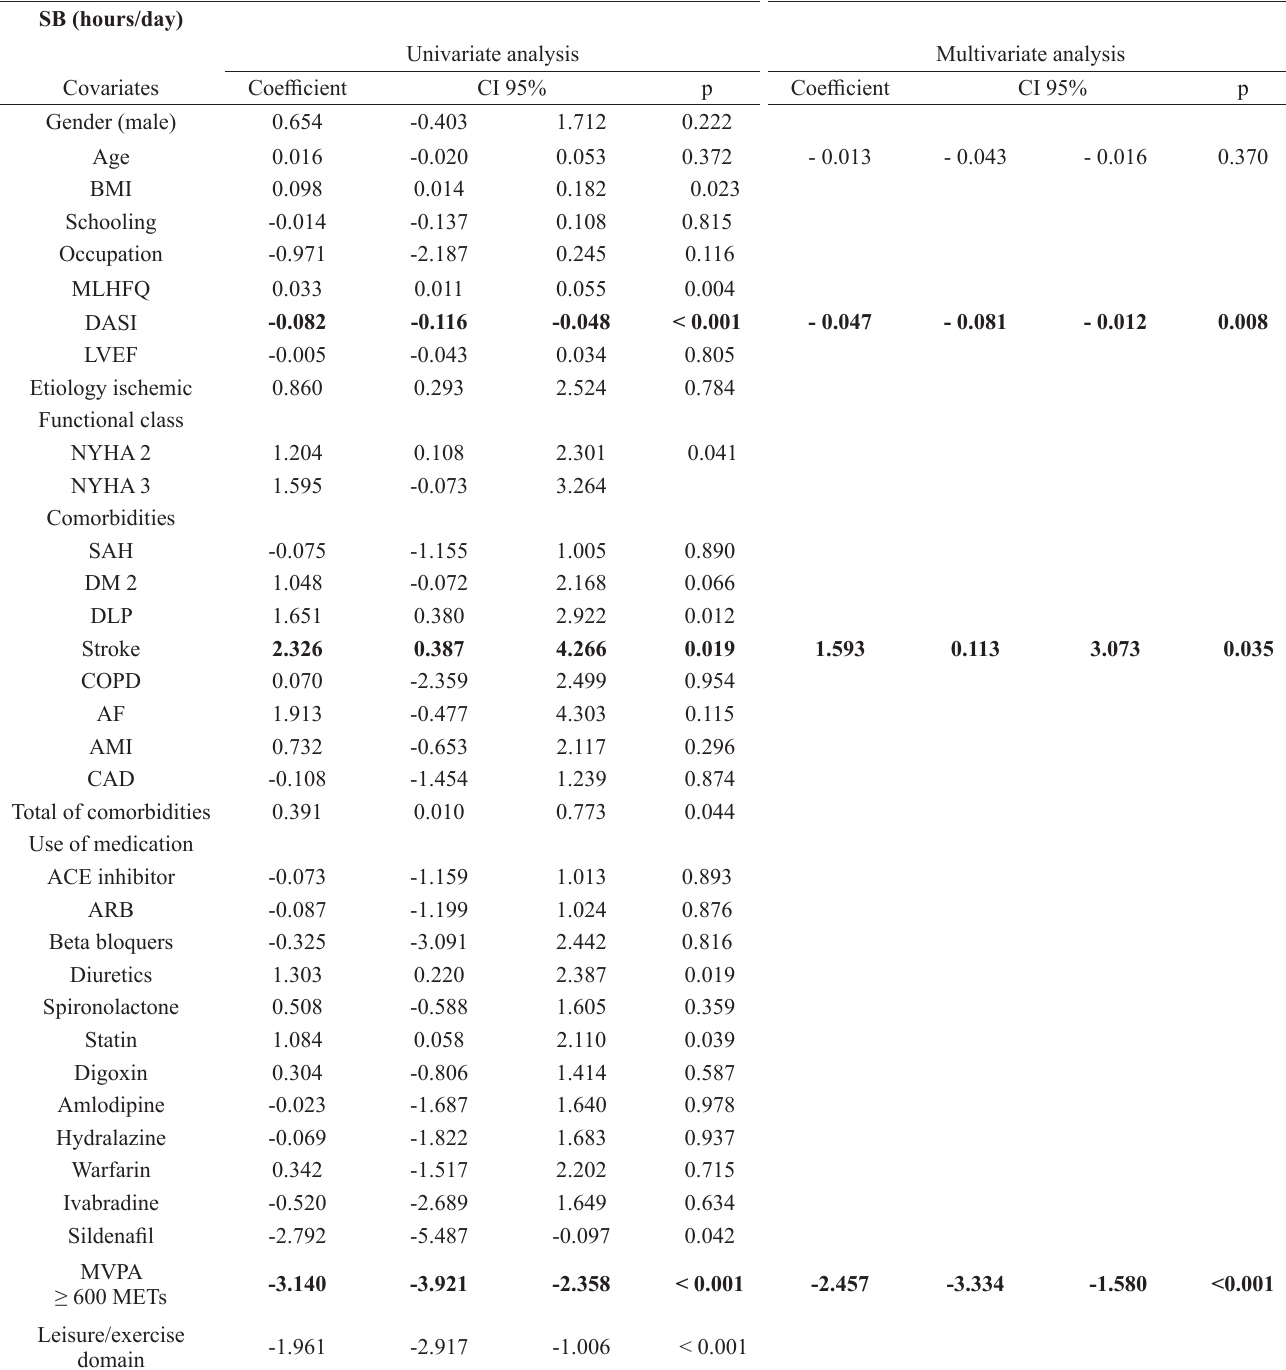
Table 2. Bivariate and multivariate associations of sedentary behavior and the covariates of the